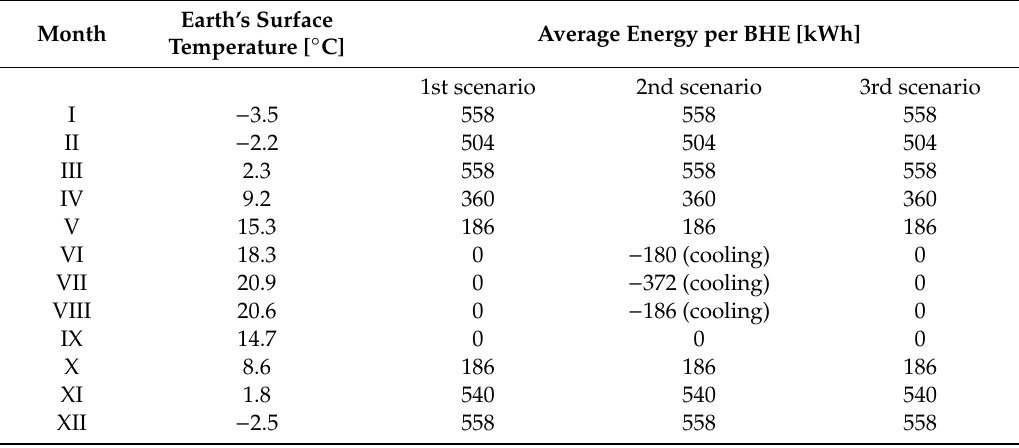
Table 2. Earth’s average temperature in the study area [32] and energy load during a